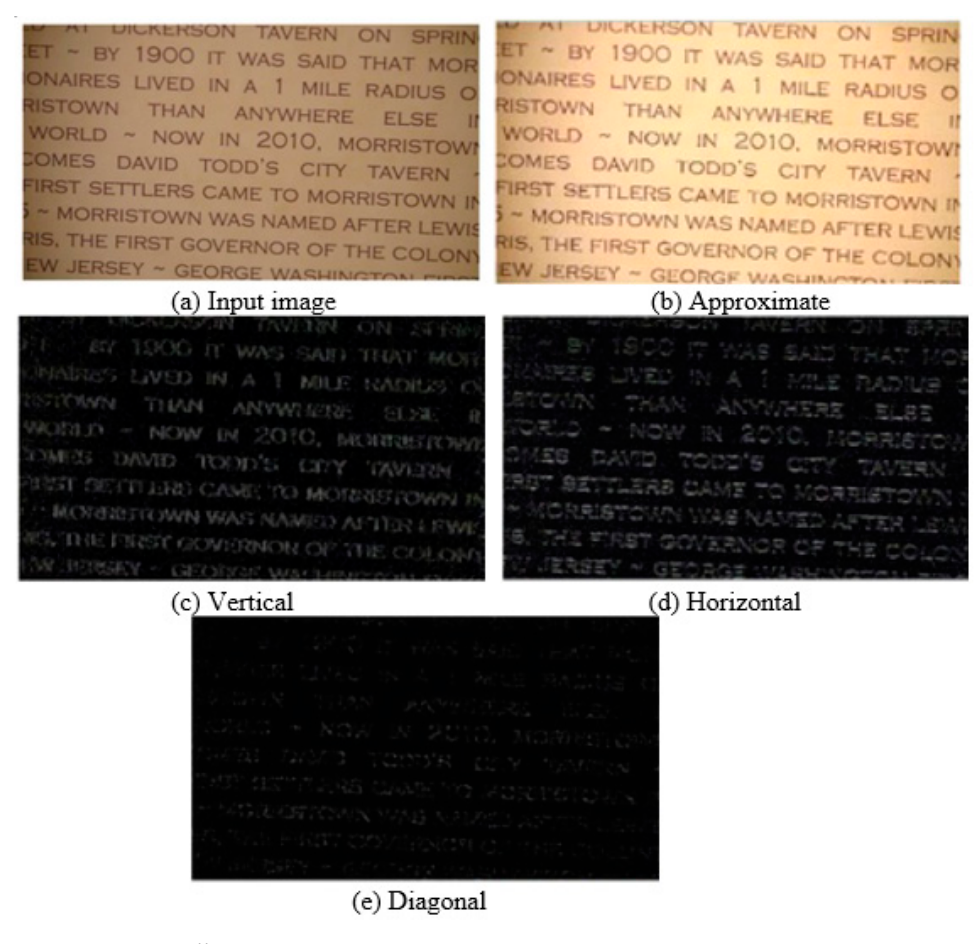
Figure 2. LWT coefficients.